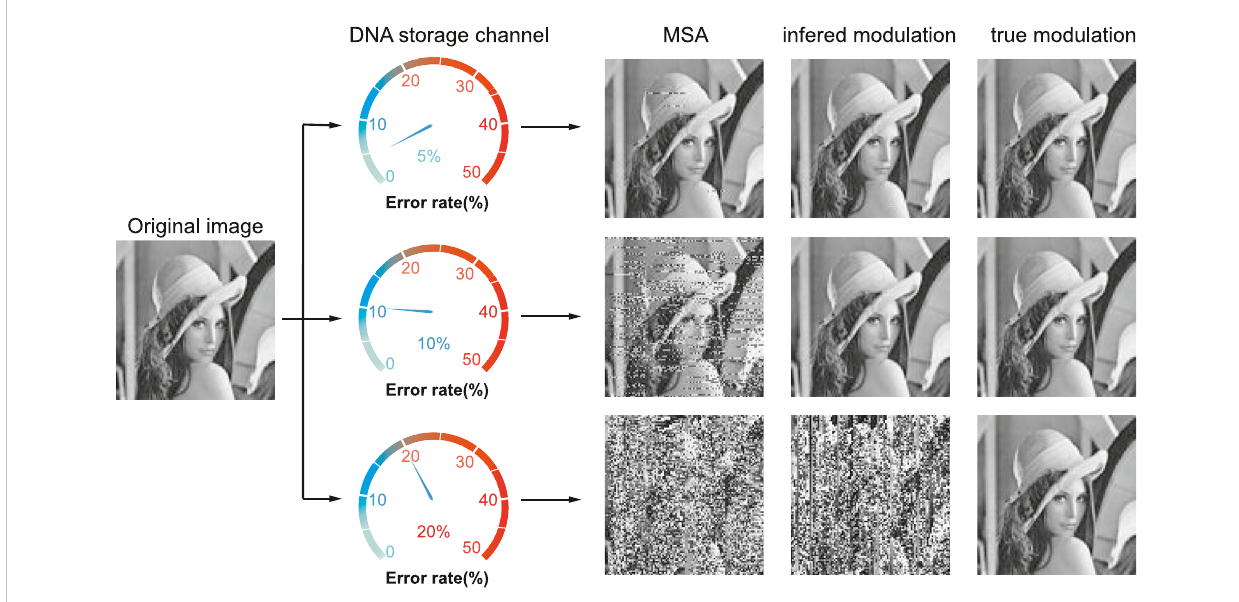
FIGURE 1 Recovered images at error rate 5%, 10%, and 20% by MSA, inferred, and true modulation signal. The recovered images by the fi rst two methods gradually become vague as the error rate increases, while the one by the true modulation signal is completely